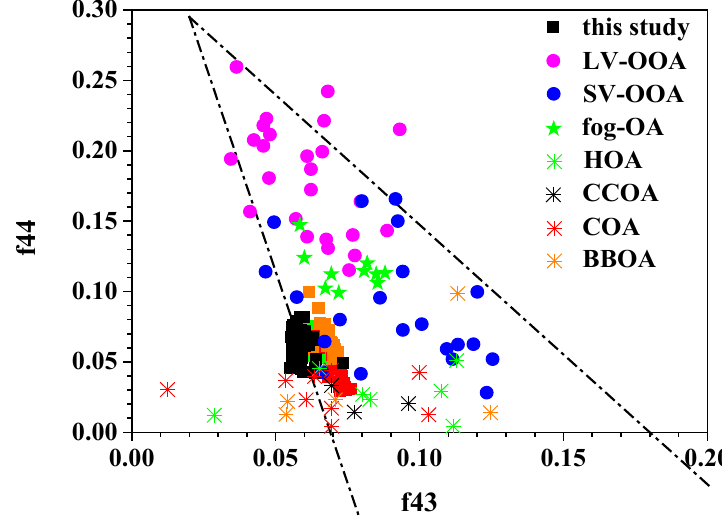
Figure 3. Triangle plot of f44 vs. f43 during the sampling periods of different seasons. The solid rectangles in green, red, orange, and black represent the data from the spring, summer, autumn, and winter of this study. Other symbols represent the data of different types of organic aerosol in the literature and the detailed information is summarized in Tables S2 and S3 of the Supplementary Materials. The fog-OA data were from the field observation results in the San Joaquin Valley, California. The dashed guidelines were derived from the data reported by [54]. The LO-OOA and MO-OOA in some studies were treated as SV-OOA and LV-OOA, as suggested by [32]. The elemental ratios of atomic hydrogen-to-carbon (H:C) and oxygen-to-carbon (O:C) in the different seasons are shown in Figure 4. The average H:C were 1.94 ± 0.05, 1.99 ± 0.04, 1.88 ± 0.06, and 1.84 ± 0.05 in spring, summer, autumn, and winter, respectively. The O:C values showed a different variation trend with H:C. The average O:C values were 0.32 ± 0.04, 0.30 ± 0.05, 0.29 ± 0.03, and 0.22 ± 0.06 in autumn, winter, spring and summer, respectively. The high H:C and low O:C values in spring and summer suggested that the organic aerosols were less aged compared to autumn and winter. It was likely due to the higher proportion of less-oxidized OA in spring and summer, while the OA in autumn and winter were more oxidized, as discussed in Section 3.2.